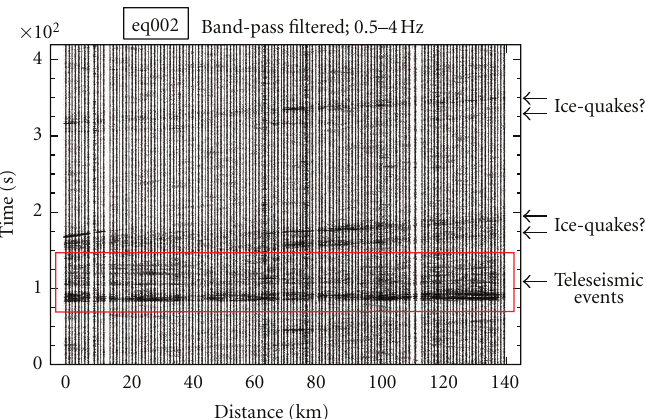
Figure 9: Band-pass filtered (0.5–4.0 Hz) waveforms of the record section containing multiple teleseismic events (event#; eq002; Southeast Indian Ridge Earthquake, and South of Fiji Island Earthquake, January 7, 2002). Major phases are clearly identified at the time-window around 100s (red colored square area). Several local (ice-related?) events are recorded as the later phases, which are raveled as “ice-quakes?”. Starting time of the slowness stacking analyses is indicated by red colored broken line (see the caption in Figure 10).